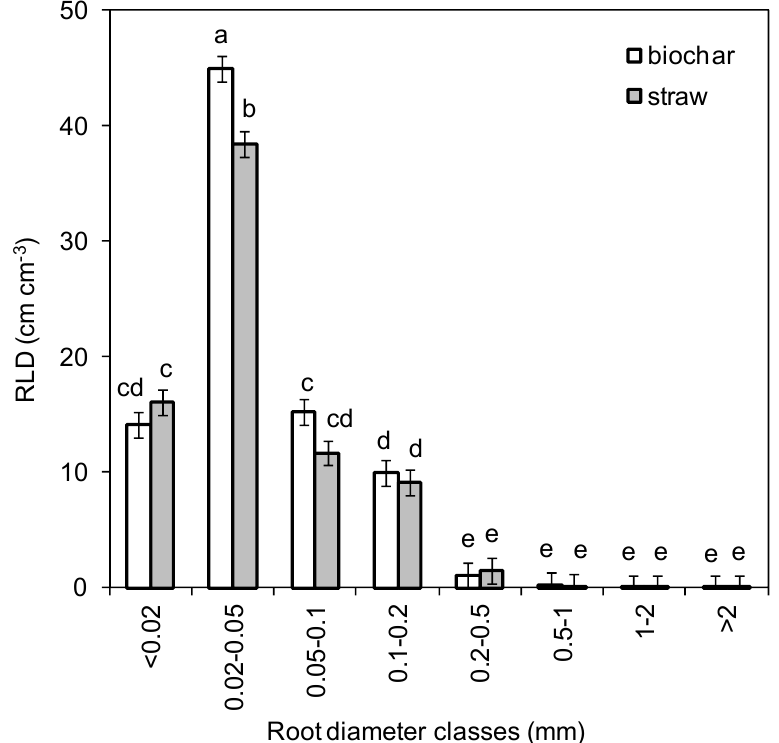
Figure 4. Root length density (RLD) of perennial ryegrass for particular diameter classes after biochar or straw application (± standard error). Different letters on the bars indicate significant differences by the Bonferroni test ( p < 0.05).